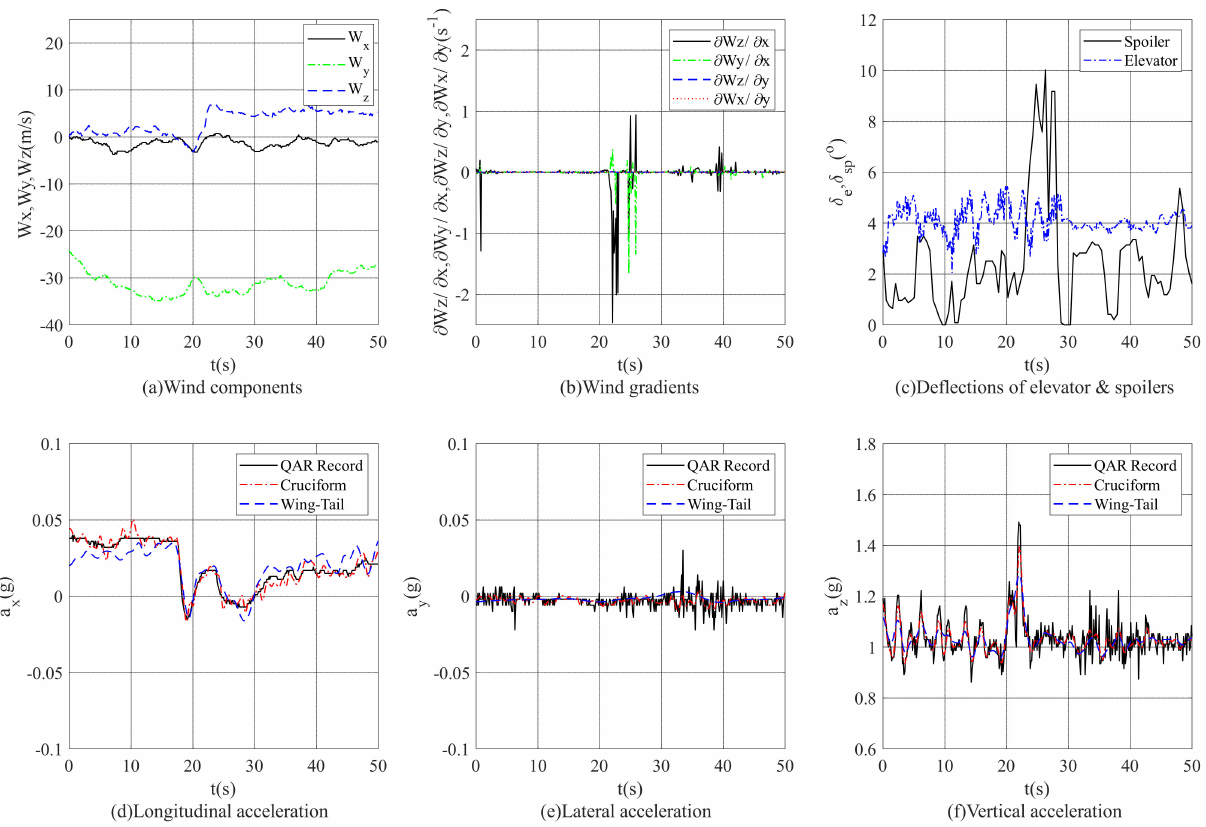
Figure 8. Aircraft response to turbulence with a large lateral component: ( a ) the three-axis wind speed components; ( b ) the four derived wind gradients; ( c ) the deflections of the elevators and spoilers; ( d ) the computed and recorded acceleration data on the longitudinal axis; ( e ) the computed and recorded acceleration data on the lateral axis; ( f ) the computed and recorded acceleration data on the vertical